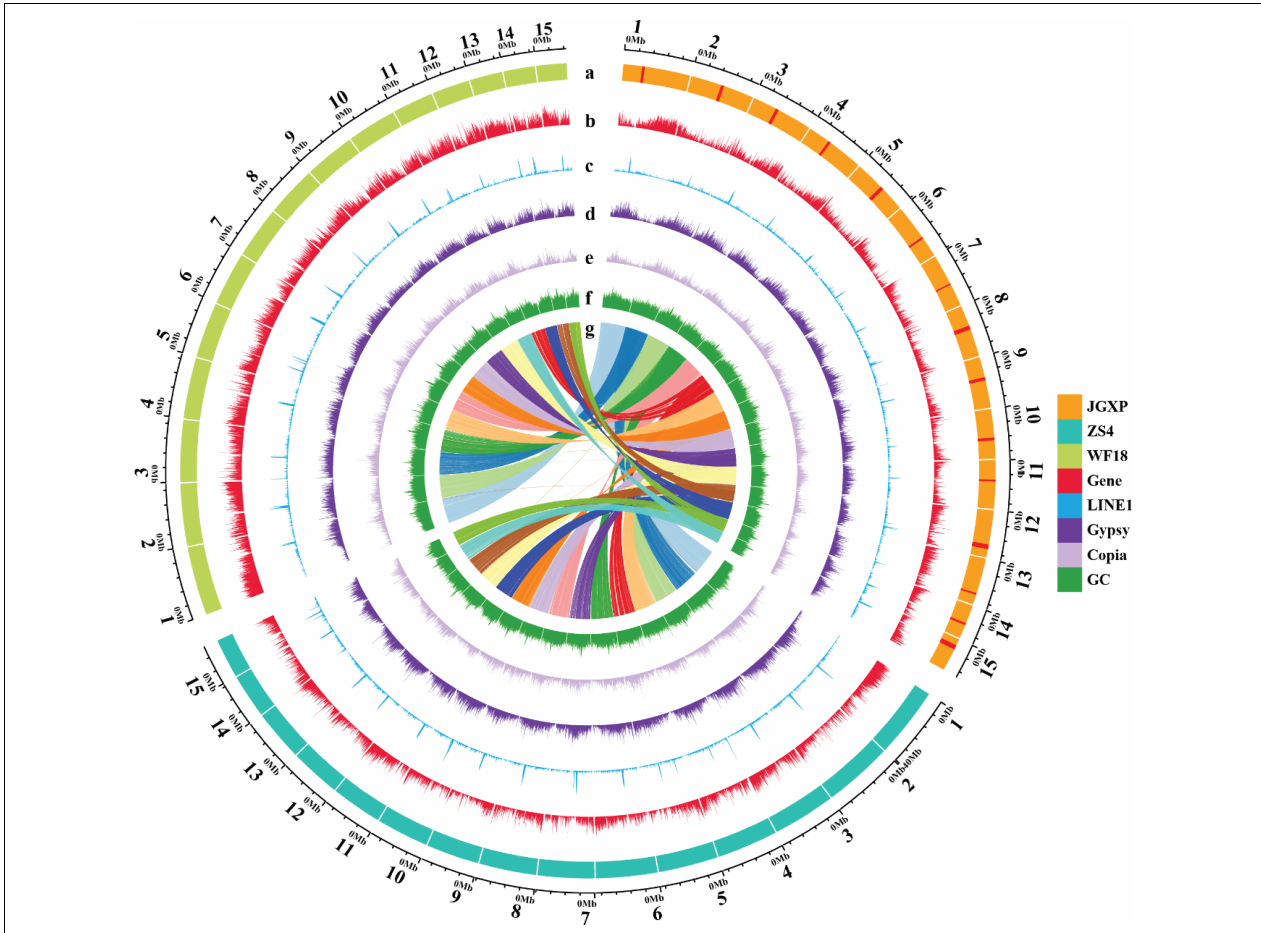
FIGURE 2 | The genomic landscape across chromosomes among the three yellowhorn assemblies of “JGXP,” “ZS4,” and “WF18.” a: The tracks represent 15 assembled chromosomes for each genome of “JGXP,” “ZS4,” and “WF18.” The red rectangles in “JGXP” represent the centromeric regions. b–f: The distribution of the gene density, LINE1 density, Gypsy density, Copia density, and GC content, respectively, with densities calculated in 100 Kb non-overlap windows. g: The homolog chromosomes among three cultivars of yellowhorn. The chromosomes of “JGXP” are used as